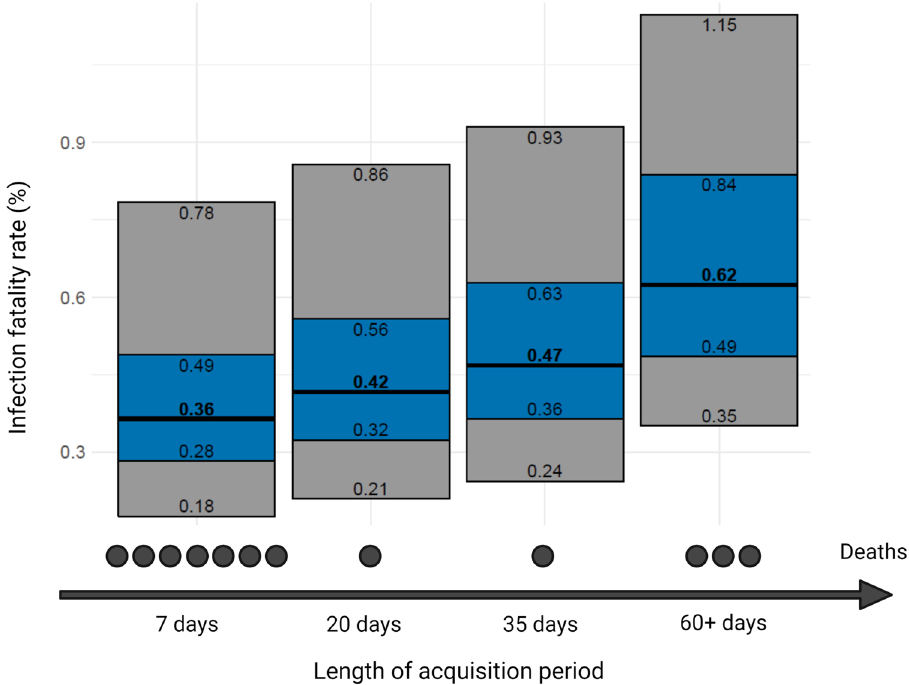
Figure 4. Newly calculated infection fatality rate (IFR) with 95% confidence intervals (blue) and 95% credibility intervals (gray) additionally accounting for uncertainty in the number of deaths. Figure was modified with bioRender.com premium (publication license available).